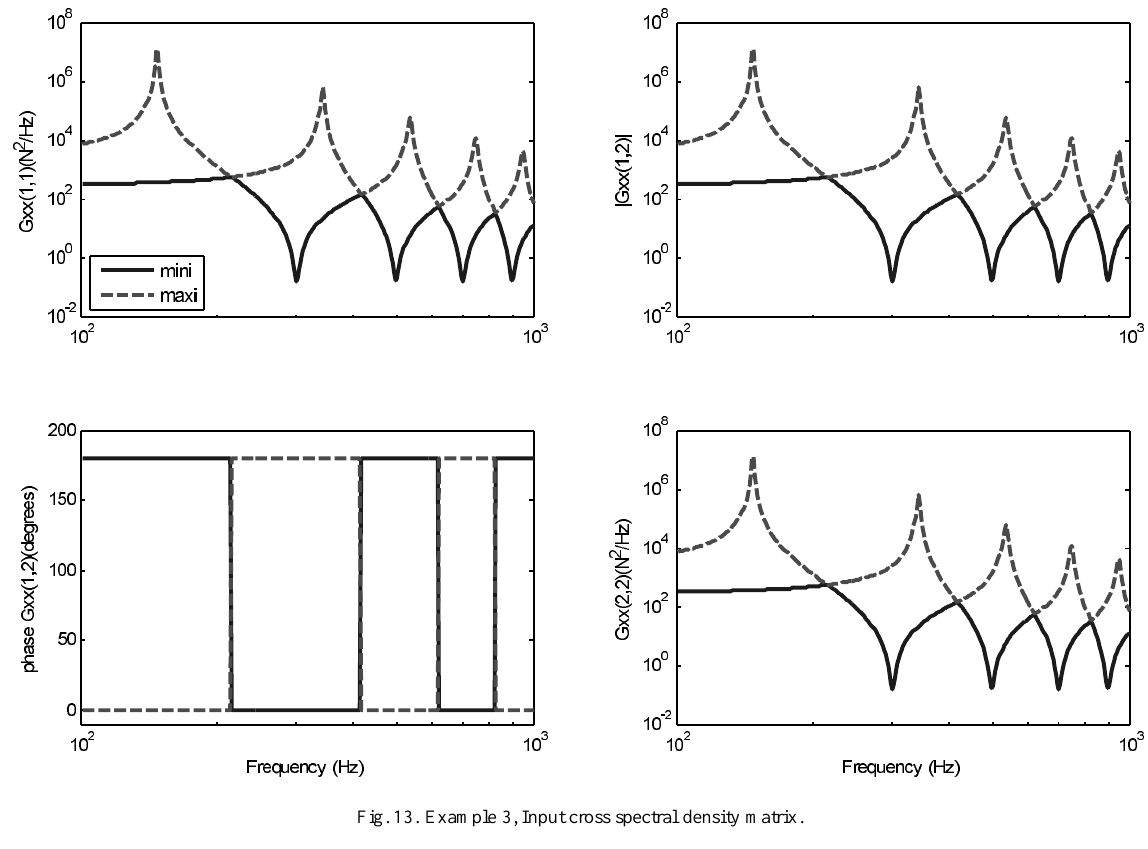
Fig. 13. Example 3, Input cross spectral density